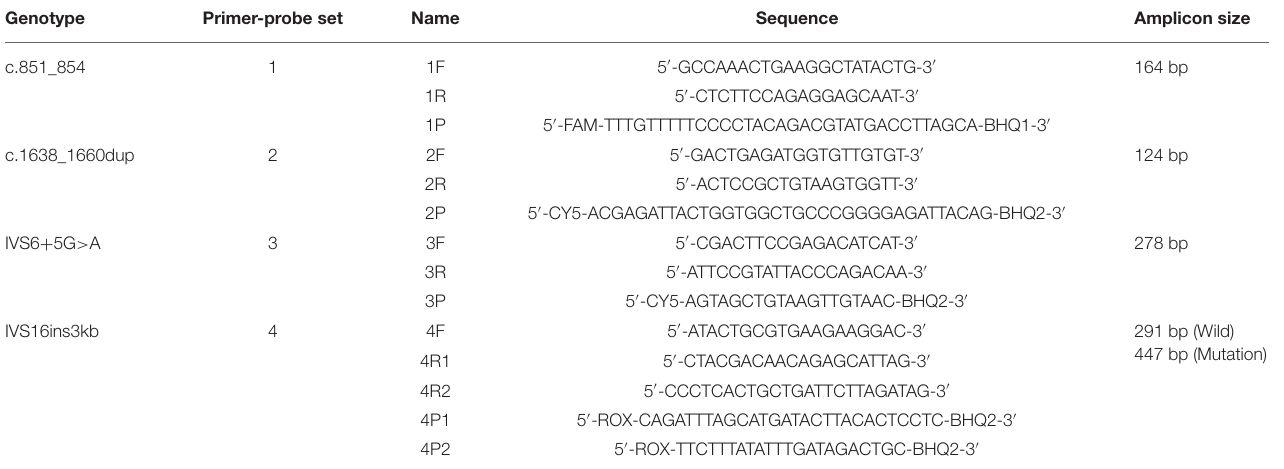
TABLE 1 | The primer-probe sets used in this